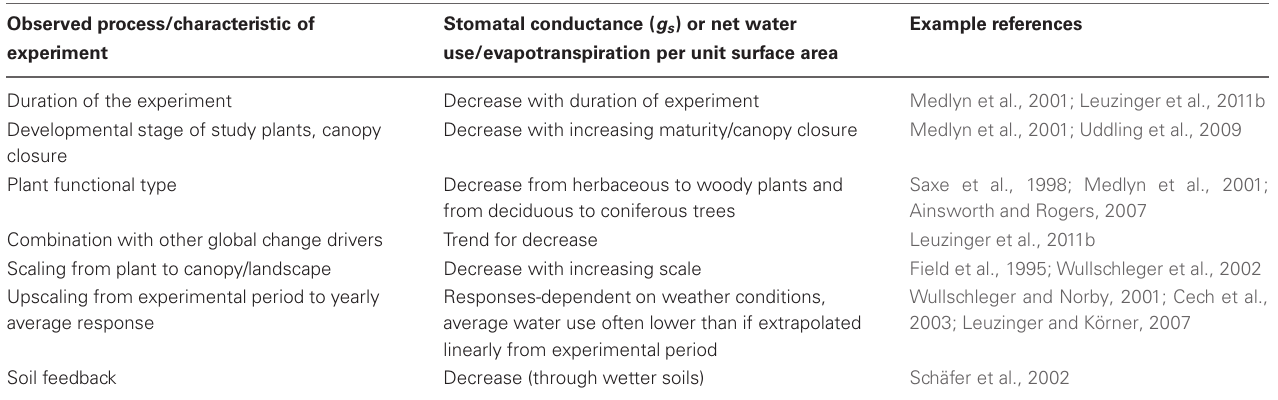
Table 2 | Possible processes that contribute to the mitigation of the response of plant water use to eCO 2